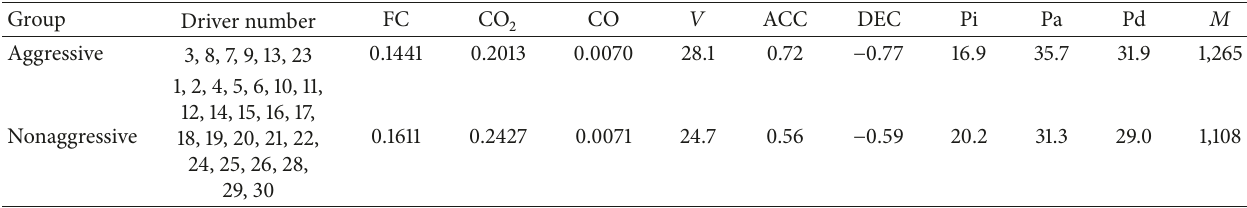
Table 3: Results of driver category by driving